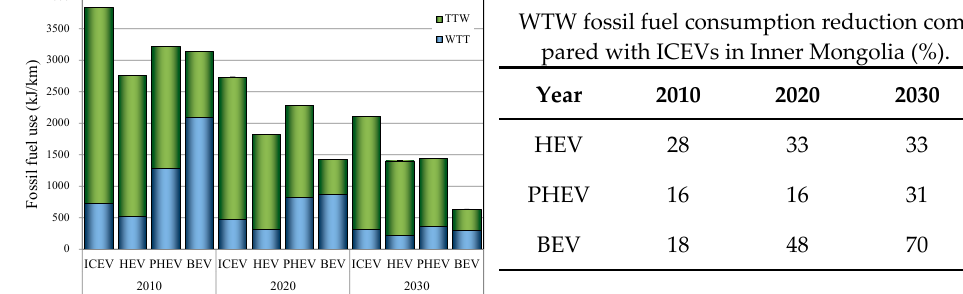
WTW fossil fuel consumption reduction com- pared with ICEVs in Inner Mongolia (%).